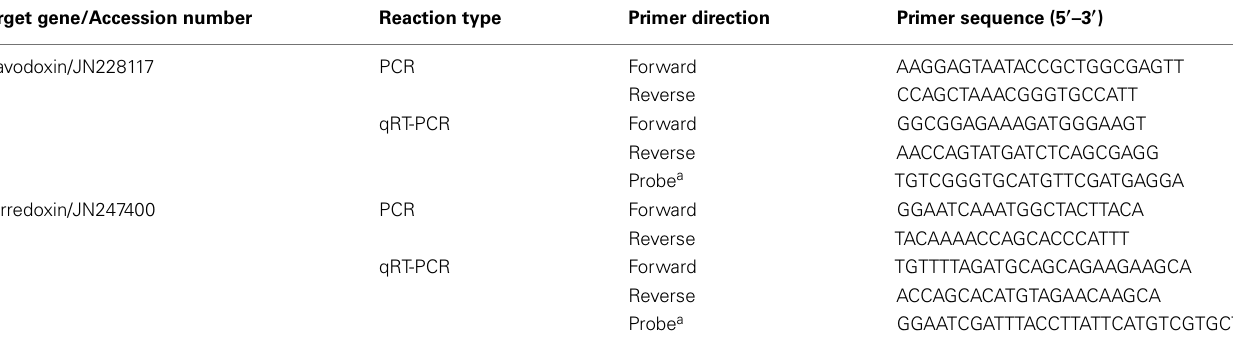
Table 2 | Genes and primers used to amplify targets for plasmid standards (PCR) and measure transcript abundance (qRT-PCR) in T. weissflogii . Target gene/Accession